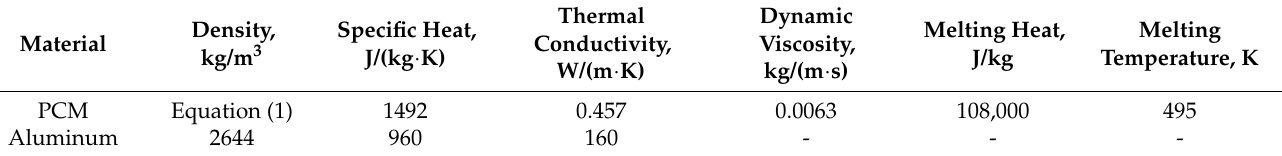
Table 2. Thermophysical properties of materials used during calculations